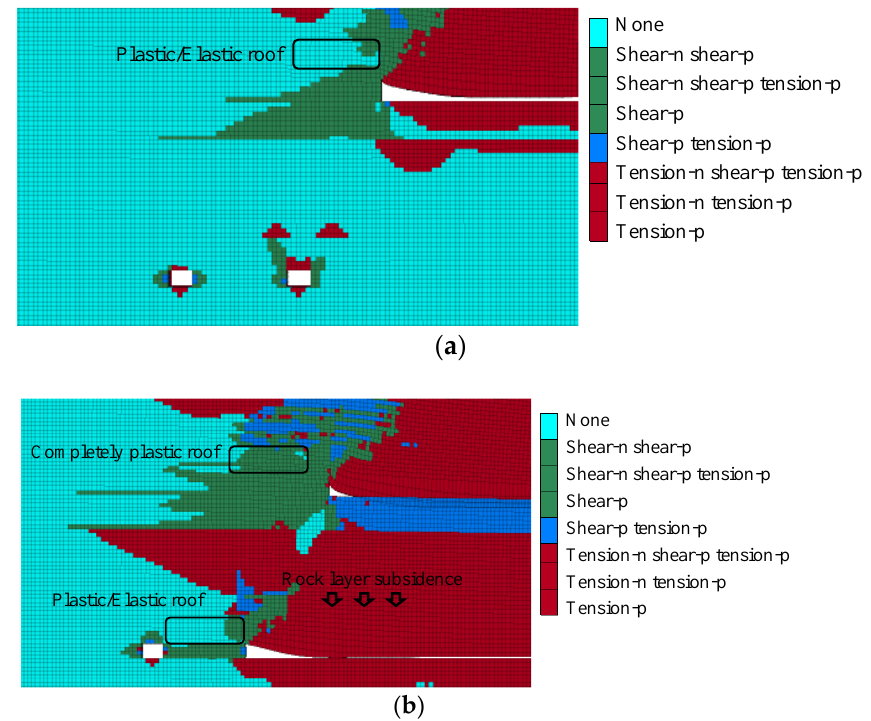
Figure 10. Distribution of plastic zones in different mining stages: ( a ) after mining of the 2 – 2 coal seam; ( b ) after the working face 31,106 is connected with the retracement roadway.